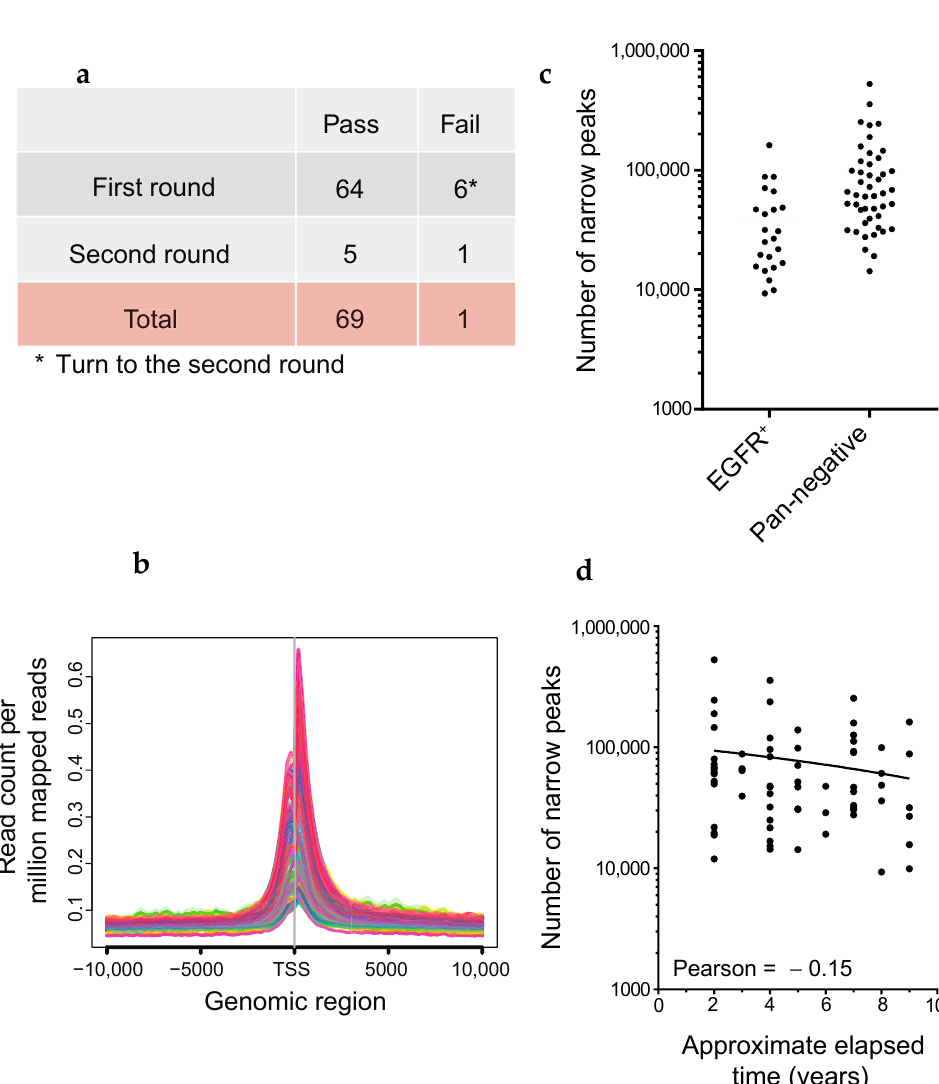
Figure 5. Quality evaluation of FFPE ChIP-seq analysis using the dual-arm robot. ( a ) Experimental strategy. The six cases denoted in the asterisk performed the second round of FFPE ChIP-seq in LUADs. ( b ) Average profile plots showing H3K27ac enrichment around TSSs ± 10 kb. The y-axis represents read count per million mapped reads. ( c ) Dot plots showing the number of called peaks generated by AIControl (see Methods). EGFR-mutant positive and pan-negative cases are shown on the left and right sides, respectively. ( d ) Scatter plot showing the number of called peaks in every elapsed period of FFPE tissues. Pearson correlation coefficient is